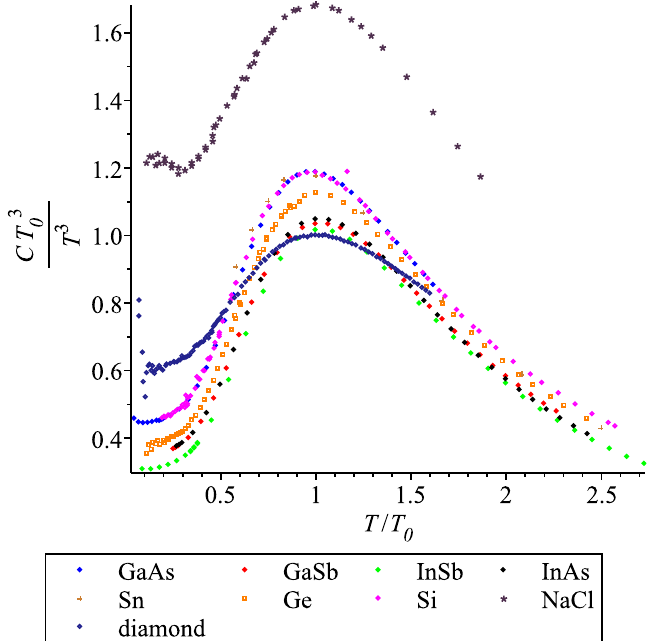
3 graphs for the diamond and zincblend lattice materials, plus NaCl, without